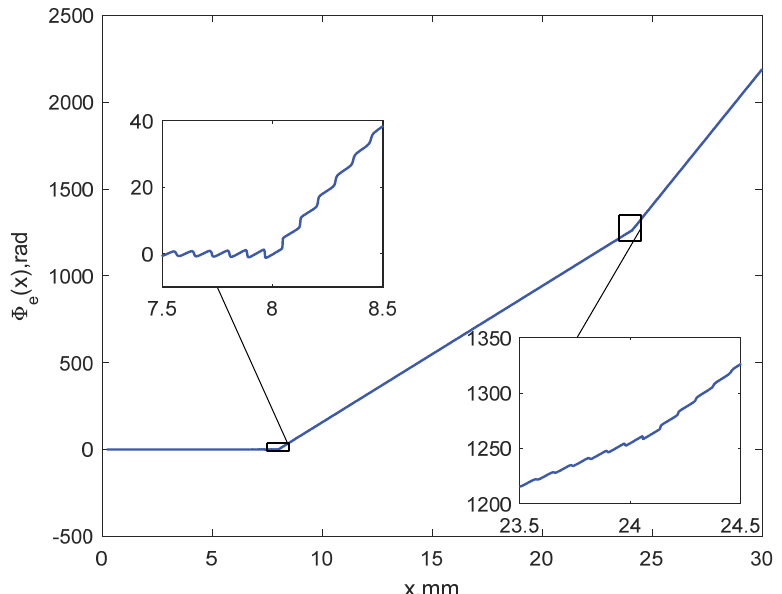
Figure 2. Phase error under the condition δ k = φ g ( X k ).